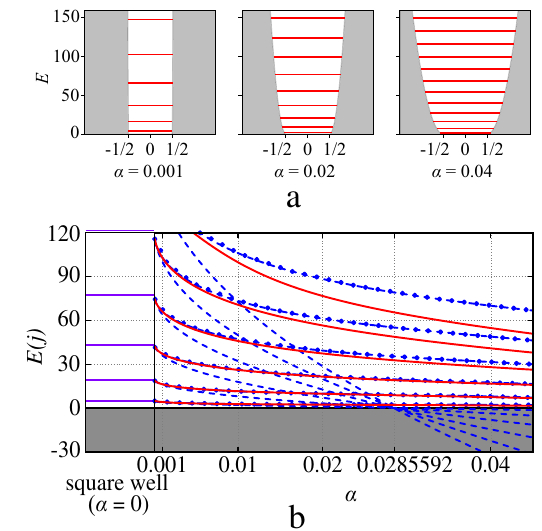
Fig. 3 Energy levels in a one-dimensional potential. a In gray, sketch of the potential V ( z ) (see text), as a function of z for L = 1, and different values of α = 1/( L 2 ω 0 ). In red, the lowest energy levels E ( j ). The fi rst six of these are shown in the bottom ( b ), as a function of α : of the continuous red line is the exact result. Blue dashed, E approx j fi rst-order perturbation theory. Blue dashed line with symbols, Þ . On the left side, the levels E ð L Þ of an connector results E j ð L c ; approx j j in fi nite potential well of width L = 1, which is the α → 0